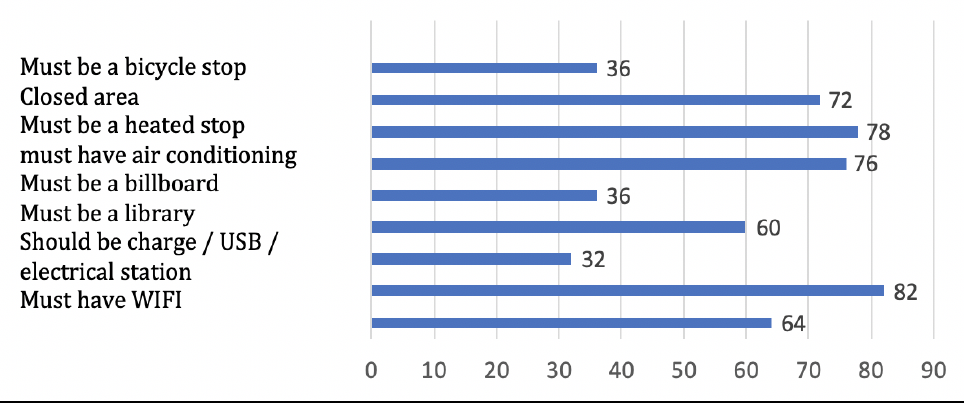
Figure 3. The scatter diagram of the items predicted to be needed